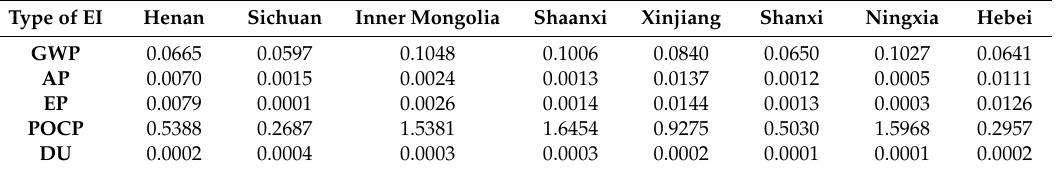
Table 6. Standardized value of the liquefied natural gas production in the eight provinces of China (p · a). Type of EI Henan Sichuan Inner Mongolia Shaanxi Xinjiang